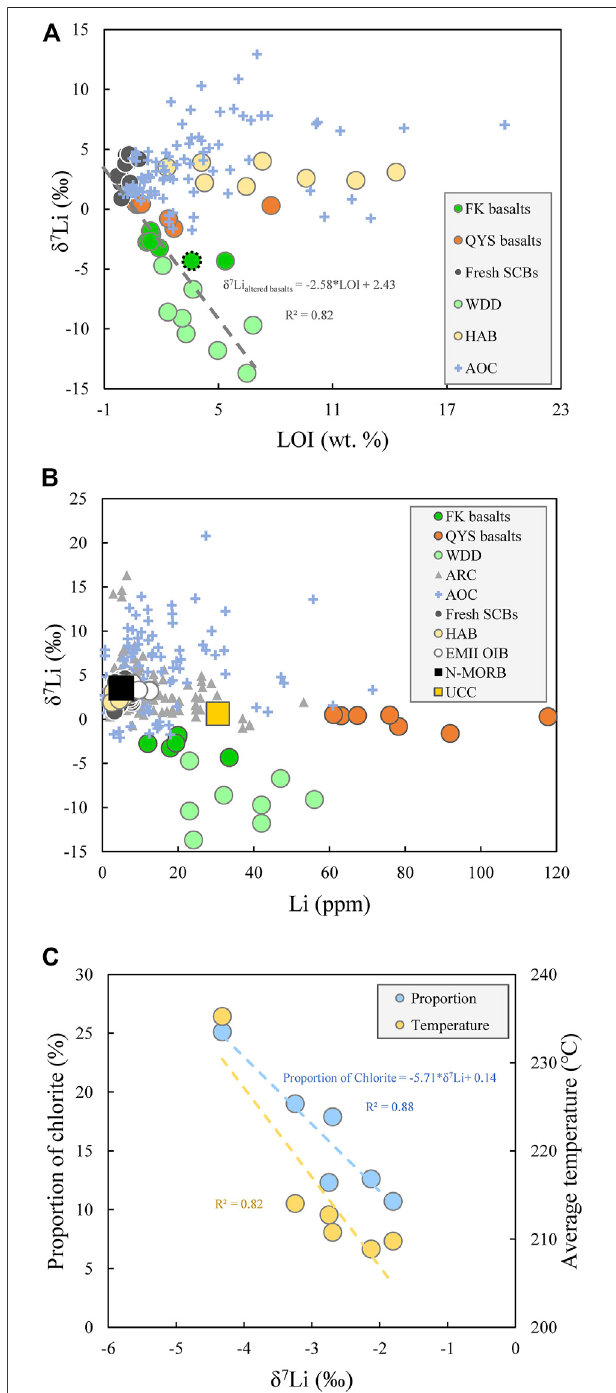
FIGURE 3 | Geochemical plots showing (A) LOI vs. δ 7 Li. The fi tted function is established on fresh SCBs, FK basalts, and WDD. For eliminating the effect of carbonates, the LOI of one sample (FK-1) was calibrated to the dotted green circle (LOI* ≈ LOI- f calcite *44). (B) [Li] vs . δ 7 Li. The fresh MORB are from the work of Marschall et al. (2017). The ocean island basalts (OIBs) from the EM2 mantle reservoir and the upper continental crust (UCC) are from the work of Krienitz et al. (2012) and Teng et al. (2008). The data ( Continued )